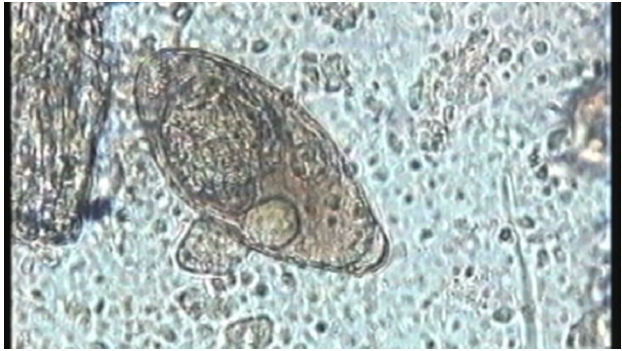
Figure 1. (Video S1) Hatching of Schistosoma mansoni egg: Miracidium rotating inside schistosome egg exposed to water. Rotational speed ~14.1 rpm (0.235 rps). Upon bursting of the egg shell (“hatching”), the miracidium rapidly accelerates to achieve a linear speed of about 0.3 mm/s (see Table 1). Digitized VHS-video recording at 15.63 FPS using microscope video camera Sony CCD-IRIS. Original magnification 200×.